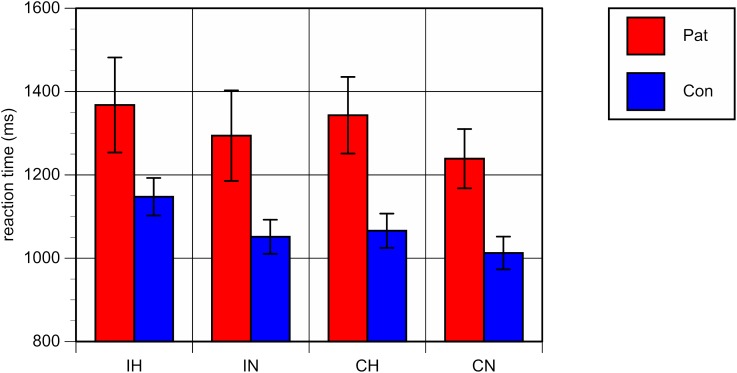
Mean reaction times (milliseconds) and standard errors for each of the four conditions. Patients with bipolar disorder in red, healthy controls in blue. IH, homonym incongruent; IN, non-homonym incongruent; CH, homonym congruent; CN, non-homonym congruent.